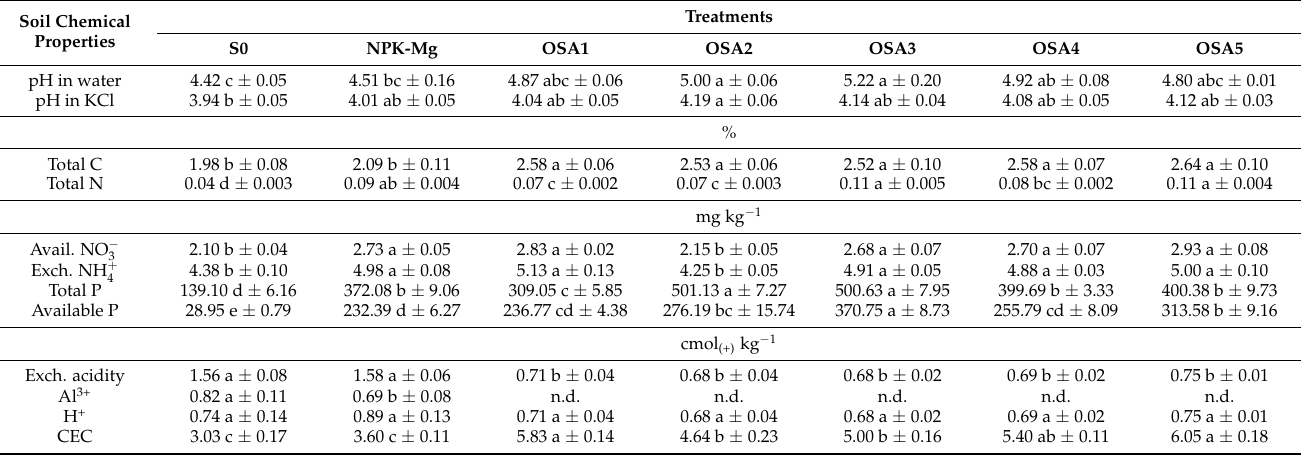
Means with different letters within a row indicate significant difference using Tukey’s test at p ≤ 0.05. Data are presented as mean of four replicates ± standard error. Note: n.d. = not